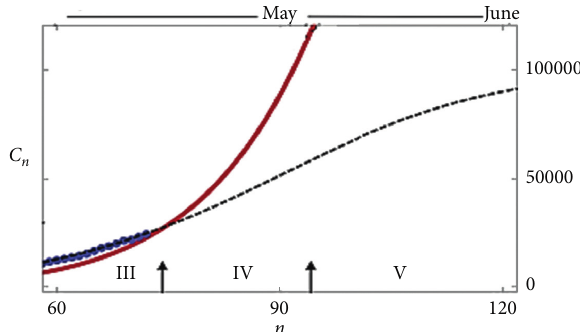
Figure 3: Confirmed epidemic ( C of June.